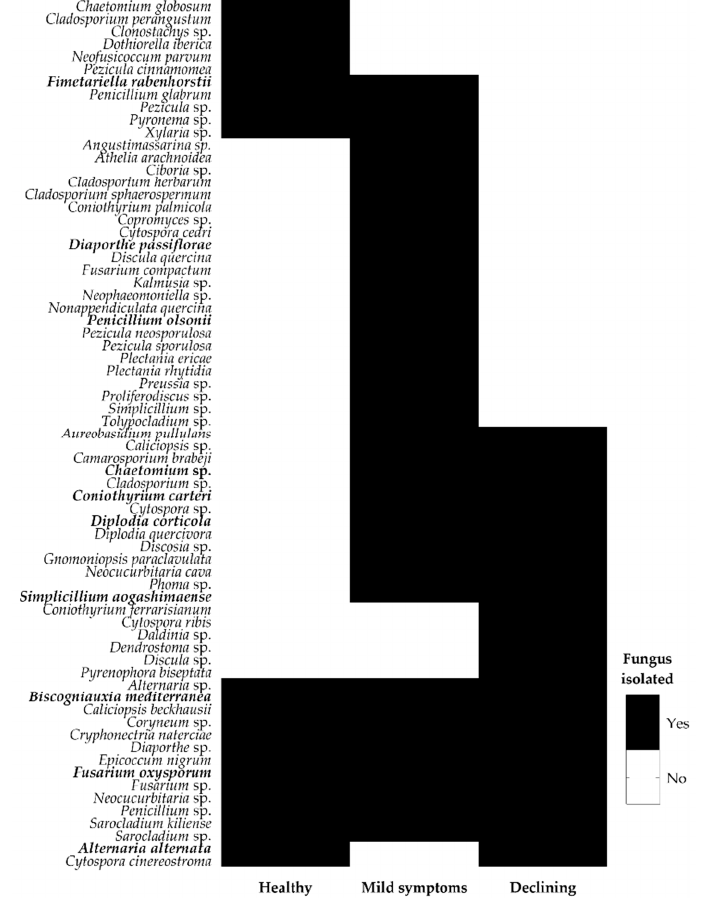
Figure 3. Endophytic fungal OTUs recovered from cork oak trees at different disease severity levels. Black/white color indicates fungal isolation/no isolation from trees with different disease severity levels. Isolates used in this work are depicted in bold.